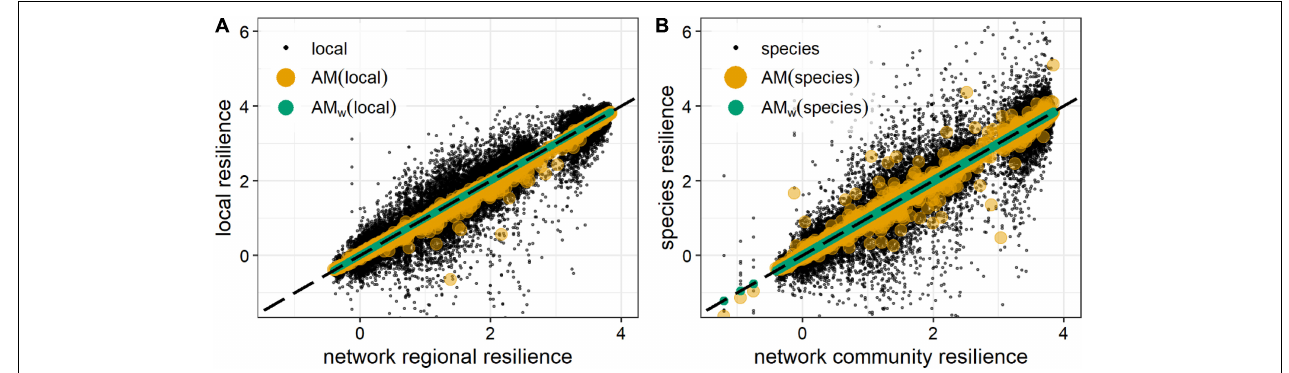
FIGURE 5 | Regional (A) and community (B) initial resiliences, compared to local and species initial resiliences and to their unweighted arithmetic mean (AM) (yellow circles) and biomass weighted arithmetic mean (AM w ) (green circles) (with weights given by the difference between the actual and the equilibrium biomasses, Eq. 17). AM and AM w values closer to the identity line (black, dashed) estimate more precisely the regional (A) and community initial resilience (B) . Black dots are the initial resiliences of the individual localities (A) or species (B) on which the means were computed. Data were generated for 6,300 random communities of 10 competitors in 10-node random spatial networks ( Supplementary Figure 1A and Supplementary Text ), after a biomass decrease from the equilibrium affecting all species at all locations. AM w are found to be better estimators of the initial resilience, as expected from the results shown in the